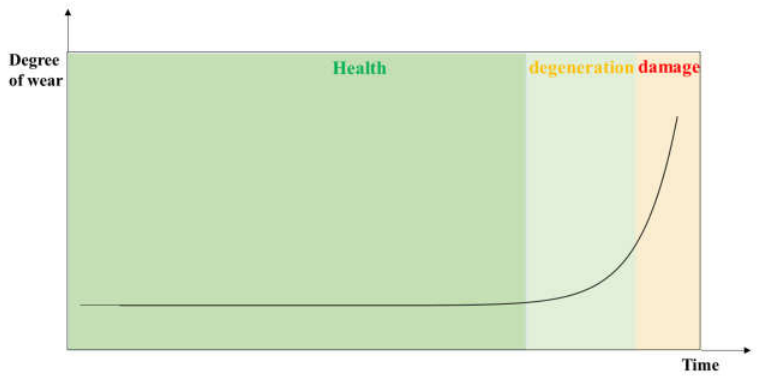
Figure 3. Bearing degradation curve.